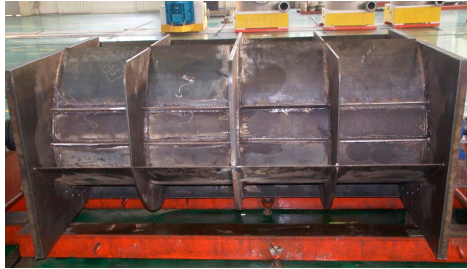
Figure 4. Horizontal axis rotor. Table 2. Engineering Prototype and Model Prototype Dimensions.